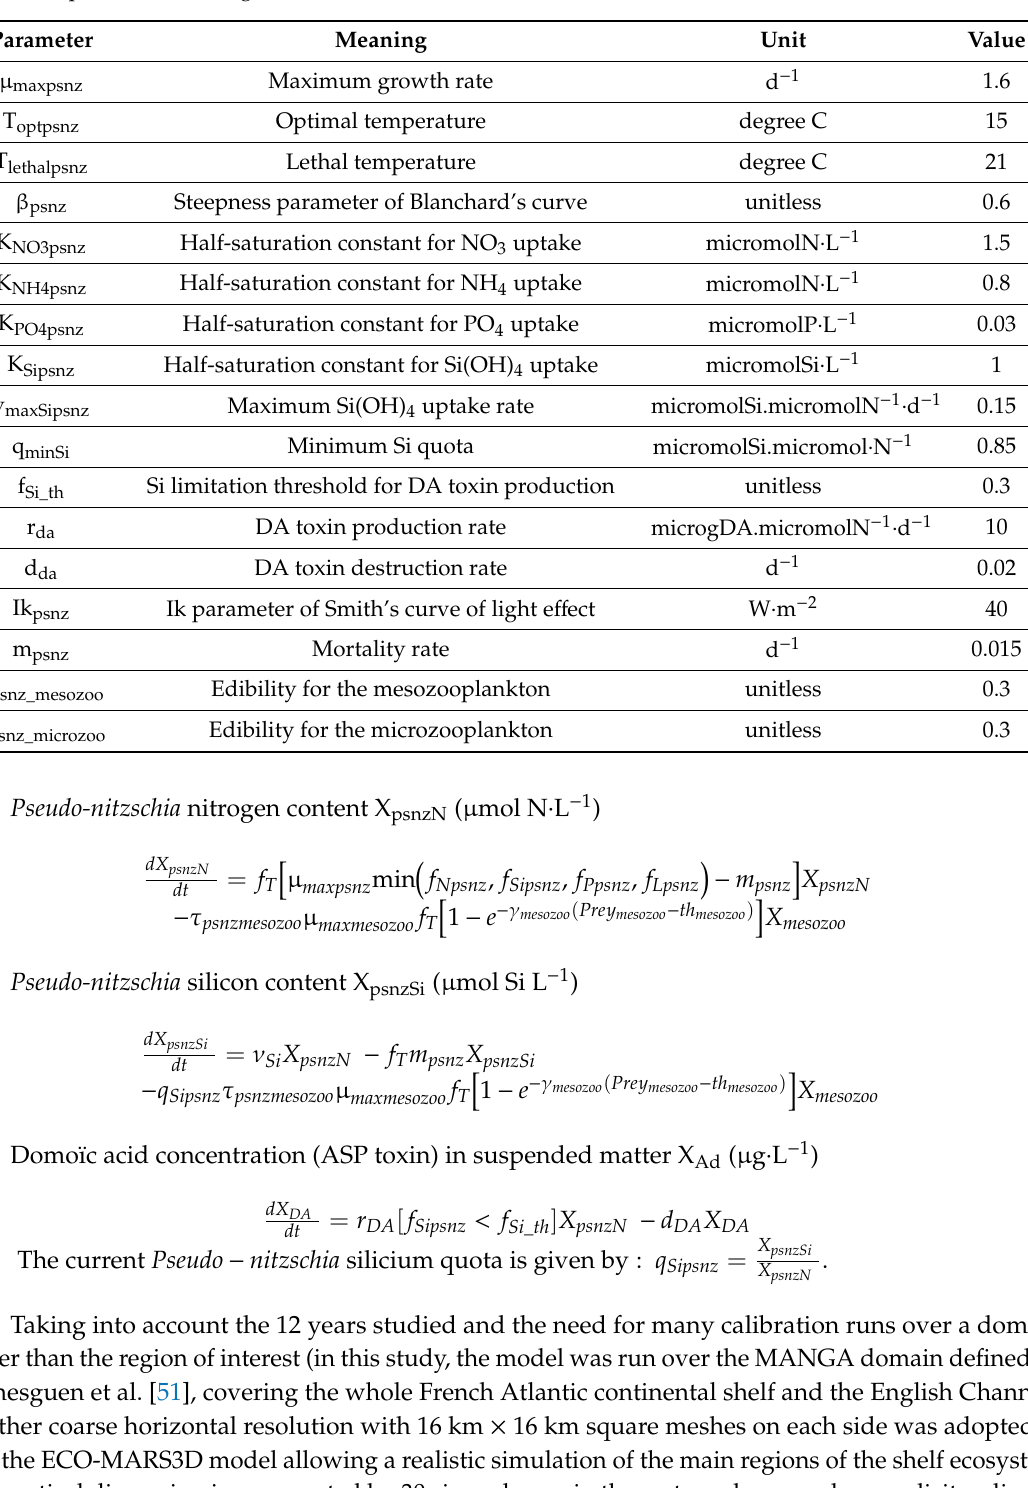
Table 3. Parameters specific to Pseudo-nitzschia and di ff erential equations associated with the Pseudo-nitzschia sub-model. State variables and parameters not specifically linked to Pseudo-nitzschia are explained in M é nesguen et al.